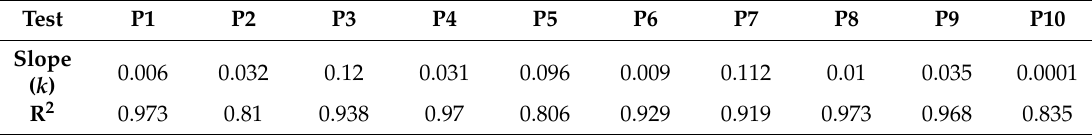
Table 10. Results for the linear regression of the chemical reaction model of all 10